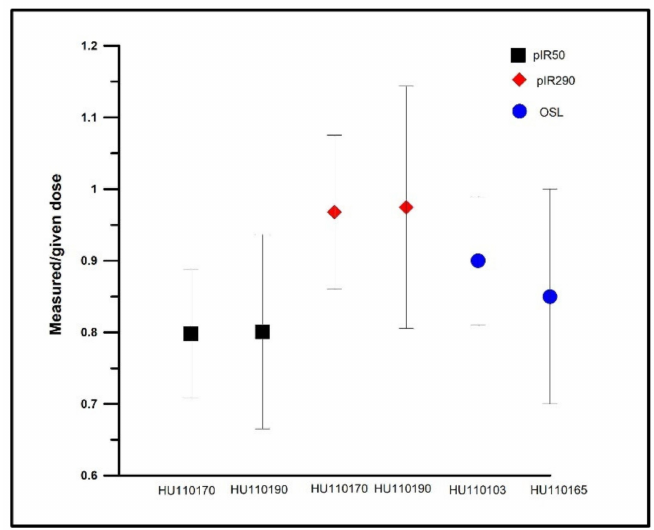
Figure 6. Ratio of measured/recovered dose rates for selected quartz and feldspar